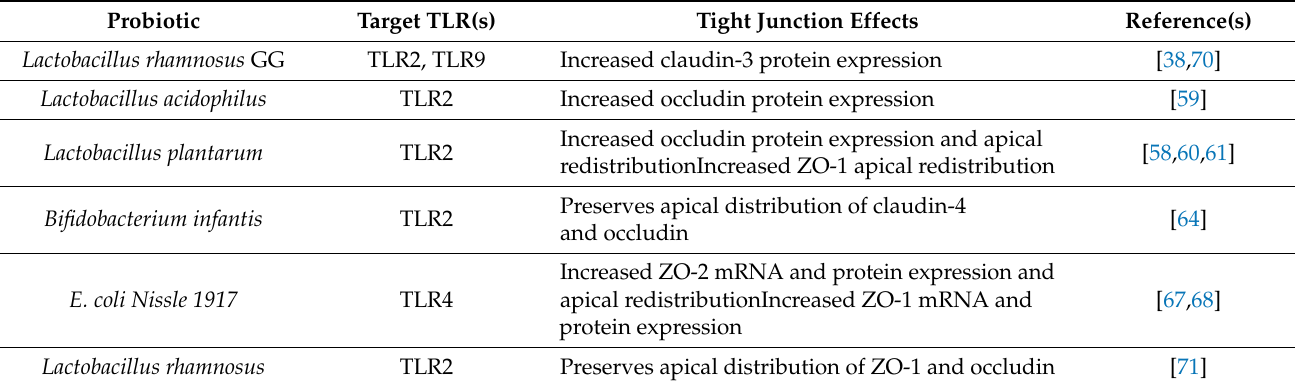
Table 1. Select probiotics target TLRs and proposed beneficial effects on intestinal tight junctions. Probiotic Target TLR(s) Tight Junction Effects